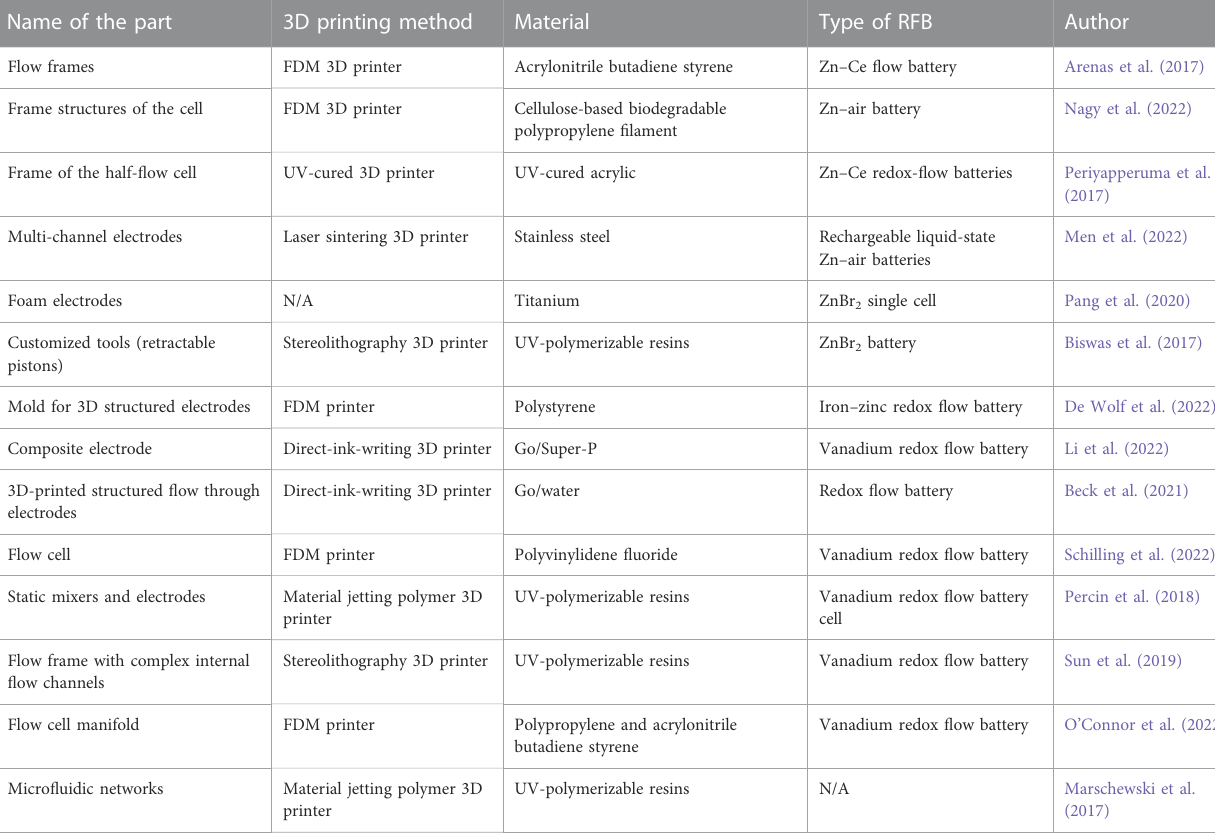
TABLE 1 Applications of 3D printing technology for the development of redox fl ow